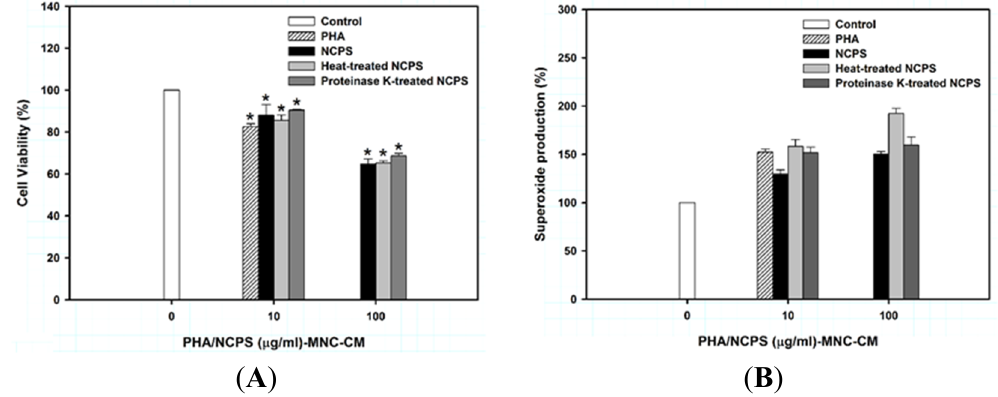
Figure 1. Cell viability ( A ) and superoxide production ( B ) of U937 cells upon treatment with MNC-CMs for three days. PHA was used as the positive control. * indicates that there is a statistically significant difference between control and treatment groups ( p <